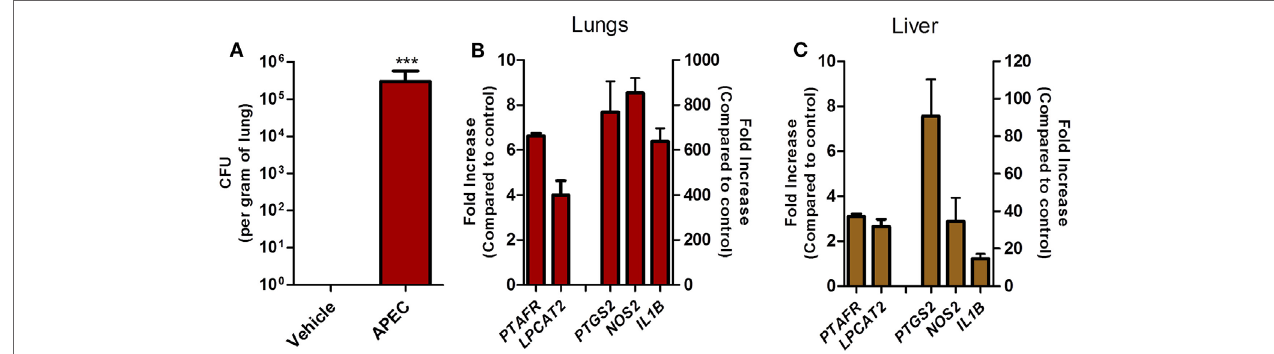
FigUre 8 | Overexpression of platelet-activating factor receptor (PAFR) and LPCAT2 is correlated with increased pro-inflammatory gene expression in chicken organs during pulmonary colibacillosis. (a) Bacterial load in the lungs of B13/B13 histocompatible white leghorn chickens at 6 h following intratracheal infection with 10 9 colony forming units of APEC BEN2908 (O2 serotype) strain. (b) Lung or (c) liver samples from APEC BEN2908-infected chickens were analyzed for PAFR/ PTAFR , LPCAT2/ LPCAT2 , COX-2/ PTGS2 , iNOS/ NOS2 , and IL-1 β / IL1B g ene expression by quantitative real-time PCR. Data are expressed as relative normalized expression (as compared to vehicle control group). Values are mean ± SEM. *** P < 0.001 when compared to negative (vehicle) control group. Sample size was six animals per